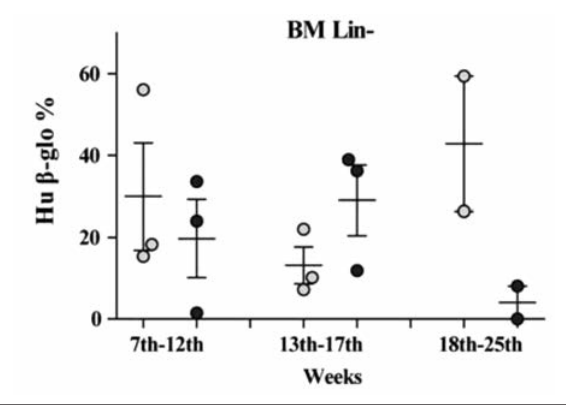
Figure 3. Human b -globin expression (%) in the PB of animals transplanted with BM Lin- cells transduced with the HS40. b or the HS2HS3. b vectors. Human b -globin expression is presented in terms of antibody mean fluorescence intensity (MFI) fold increase over untransduced control mice and in three time peri- ods after transplantation. Symbols represent individual